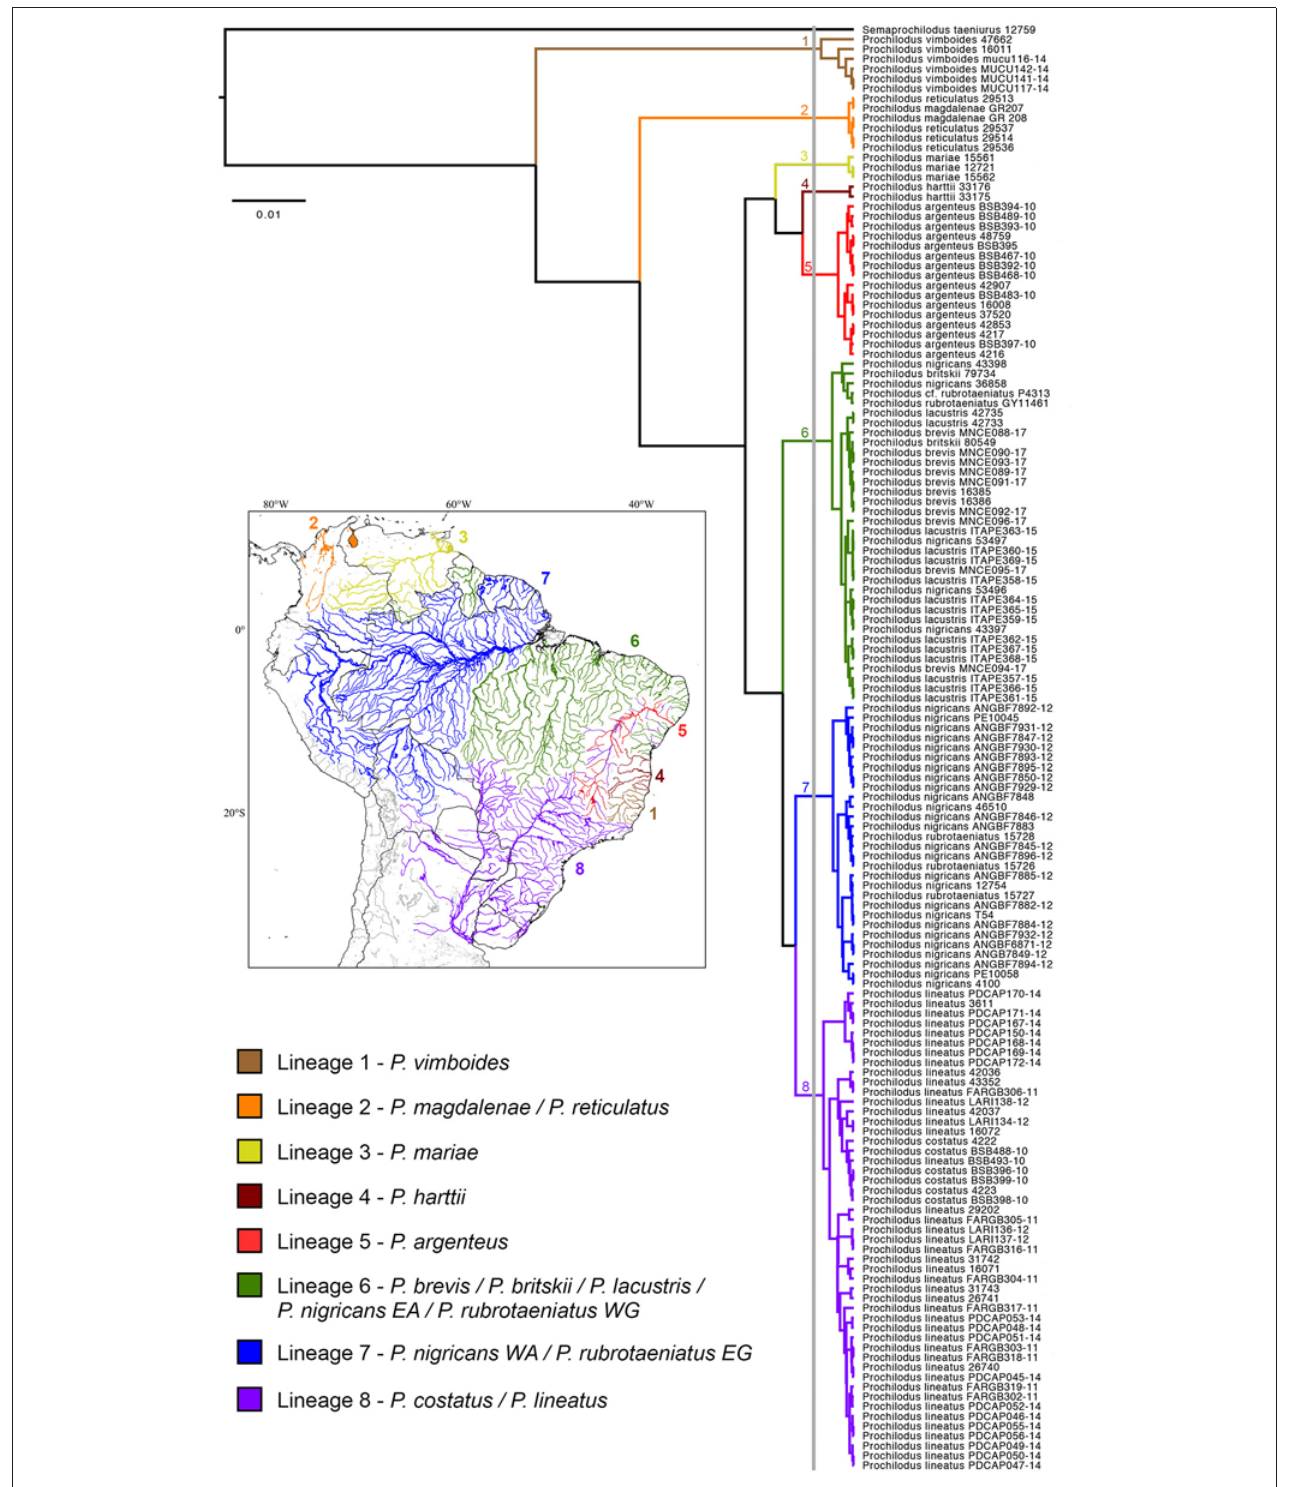
FIGURE 1 | Species delimitation tree based on a Bayesian GMYC analysis showing the single threshold delimiting cladogenetic events at left of the vertical gray bar. Numbers near nodes represent each mitochondrial lineage. All clusters representing species received posterior probabilities = 1. The South American map at left shows the distribution of the genetic lineages of Prochilodus